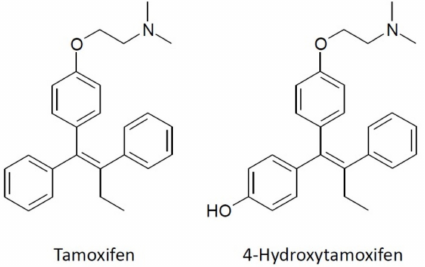
Figure 1. The chemical structures of tamoxifen and 4-hydroxytamoxifen.